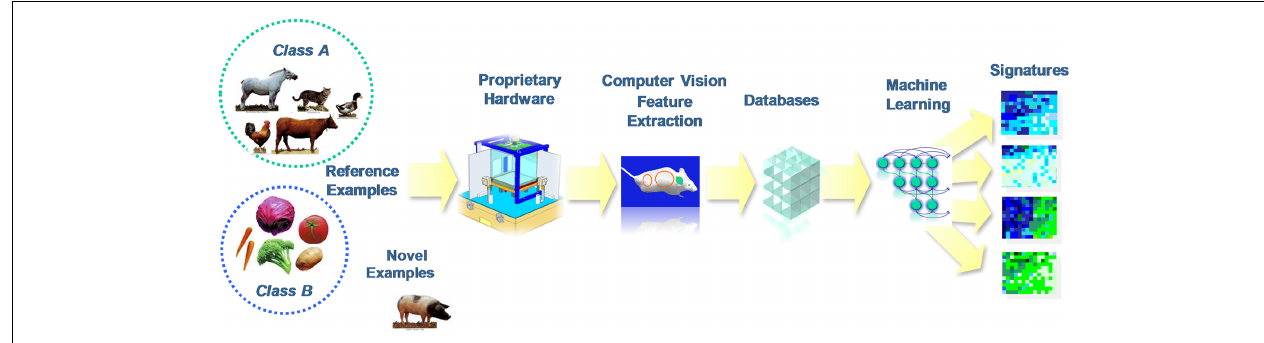
FIGURE 1 | PGIAnalytical Systems combine proprietary hardware, robotics, computer vision, and data mining techniques to collect thousands of behavioral features in a single test session and extract unique signatures for each compound. These signatures are compared with the signatures obtained from reference compounds (shown to have clinical efficacy) in different therapeutic classes and subclasses to predict clinical